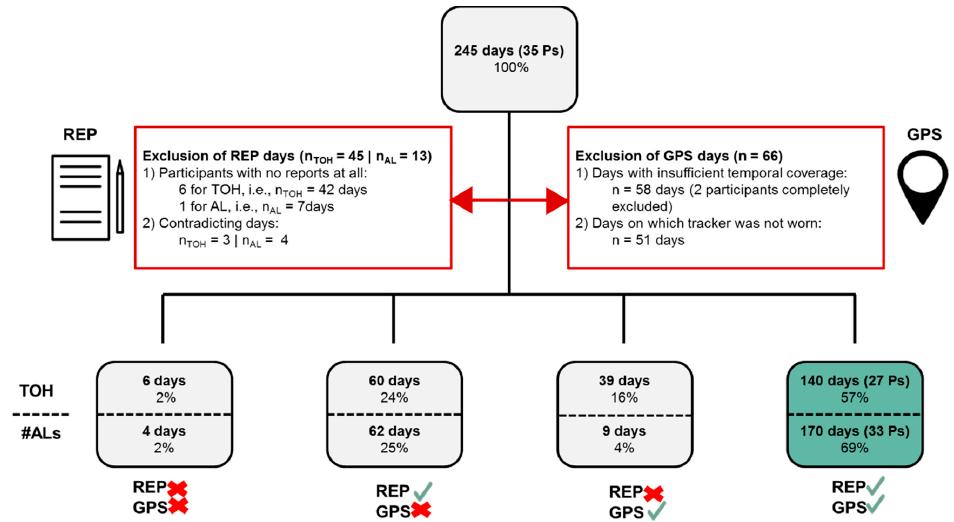
Figure 6. Exclusion of initial number of study days and participants (Ps) (top box) based on inclusion criteria for reported data (REP, left red box) and GPS data (right red box); and number of resulting days with no valid data at all, only valid reported data, only valid GPS data, and matching valid REP and GPS data (bottom boxes).